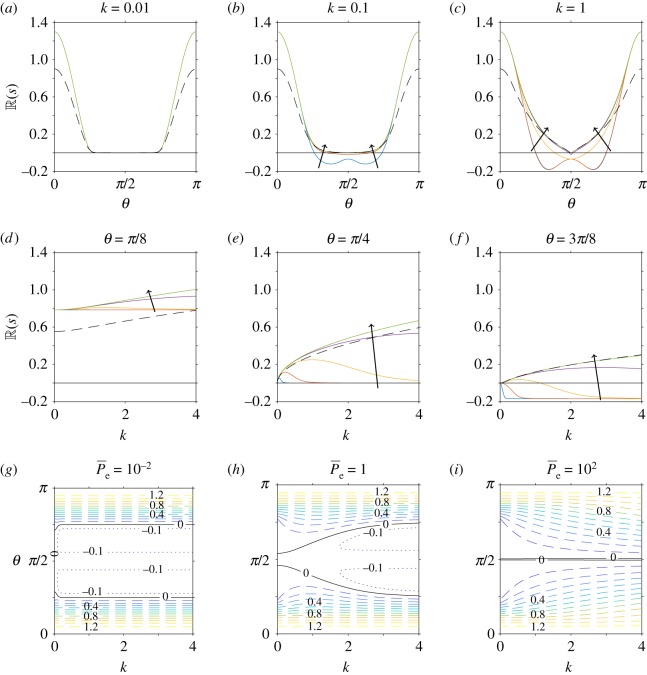
Linear stability analysis of a nearly aligned suspension, for variations in translational diffusivity (Péclet number) when mechanically anisotropic effects are included. In all plots, the volume fraction, shape parameter and stresslet strength are constant (ϕ = 0.2, α0 = 0.8 (equivalent to Γ = 3), α1 = − 1). (a–f) The real part of the growth rate (R(s)) for changing Péclet number P¯e=10−2, 10−1, 1, 101, 102, where the arrow indicates the direction of increase. The dependence of R(s) on the wave-direction θ is shown for fixed values of the wavenumber (a) k = 0.01, (b) k = 0.1, (c) k = 1, and the dependence of R(s) on k for fixed values of (d) θ = π/8, (e) θ = π/4, (f) θ = 3π/8. The dashed line corresponds to ϕ = 0 and 1/P¯e=0, i.e. the diffusion-free regime considered by Saintillan & Shelley [32]. (g–i) The dependence of R(s) on k and θ for fixed values of (g) P¯e=10−2, (h) P¯e=1 and (i) P¯e=102. Here the spacing of contour lines represents a change of 0.1 to R(s). The black solid line in all plots indicates R(s)=0, i.e. the boundary between instability and stability.